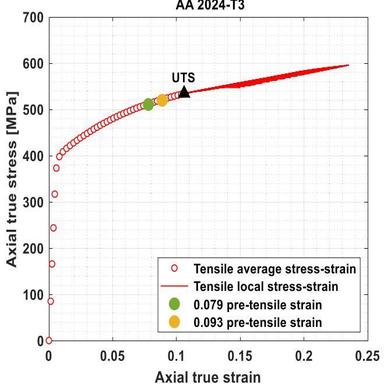
States of pre-tensile strains as seen by ultimate tensile strength comparison.